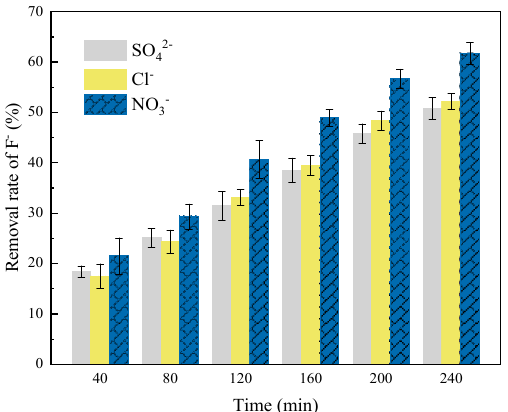
Figure 11. Removal of fluoride ions with different competing ions. The Mn-Ti modified zeolite (2 g) was mixed in a 0.1 L solution with 1 × 10 − 2 g/L initial fluoride concentration at 25 °C and the test time was 4-h.